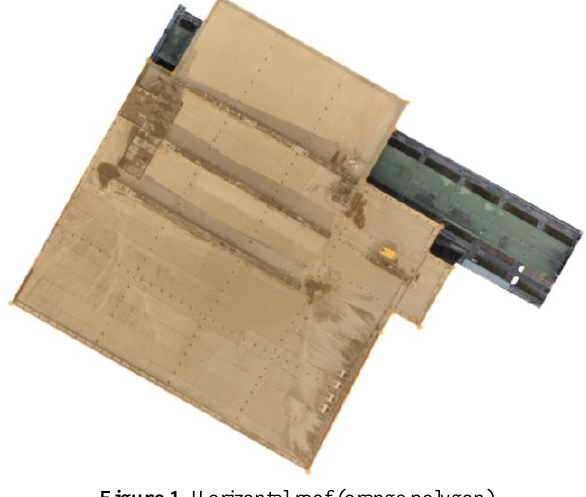
Figure 1 . Horizontal roof (orange polygon)